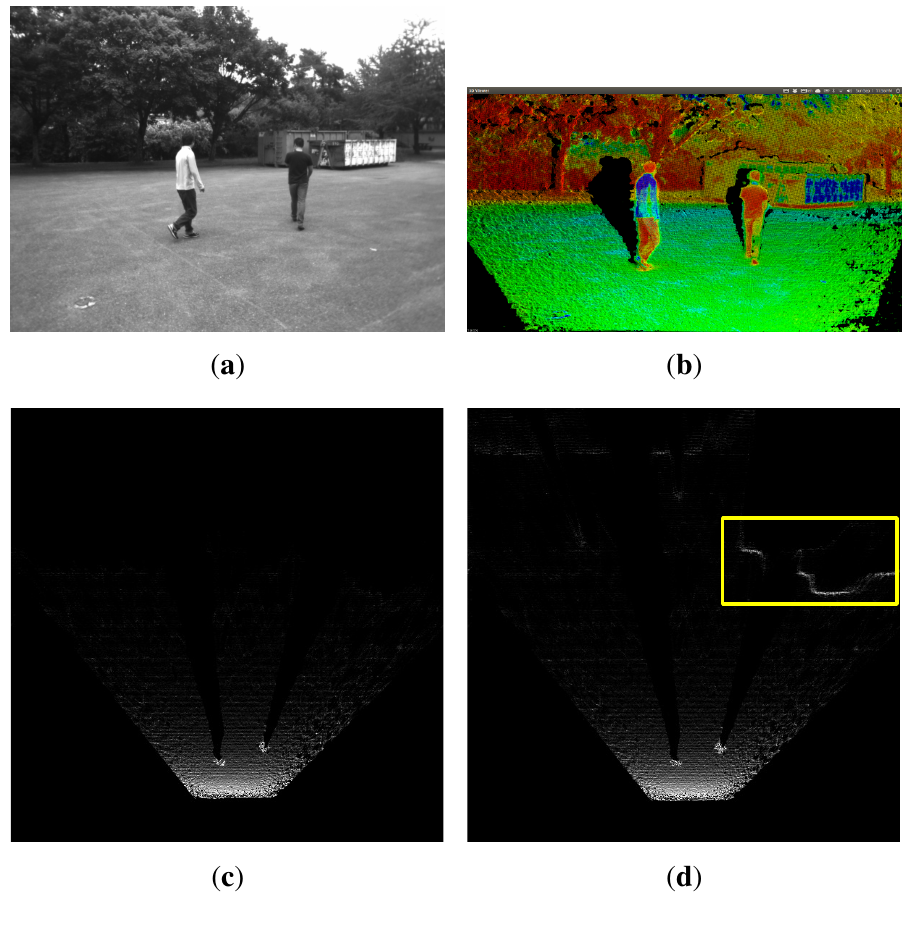
Figure 7. The effect of pitch angle correction. ( a ) A scene consisting of two pedestrians and obstacles; ( b ) 3D reconstruction from the disparity image; ( c ) projection of all of the 3D points to the ground before pitch angle correction; ( d ) projection of all of the 3D points to the ground after pitch angle